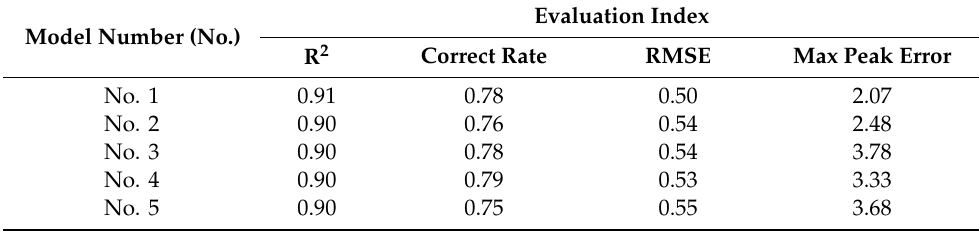
Table 7. Evaluation index value of each model (all experiment patterns = 60